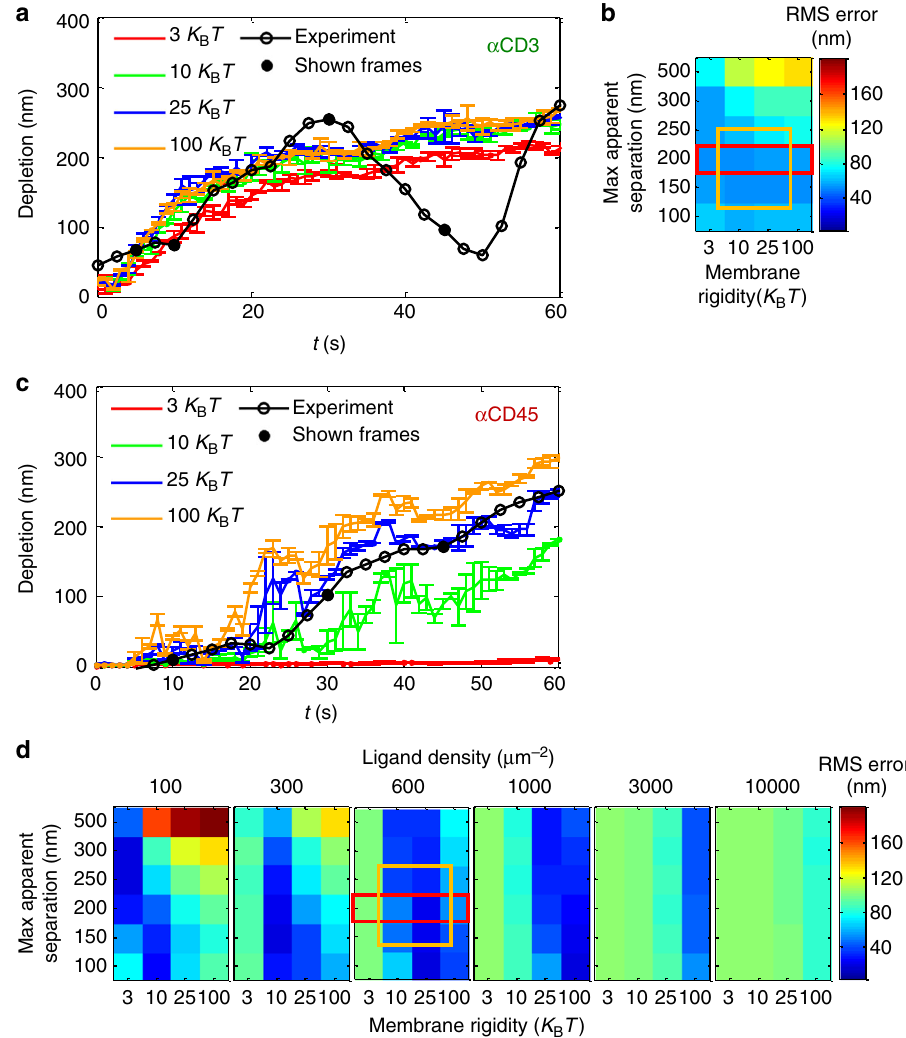
Fig. 5 Modelling and simulations serve to quantify the effect of physical properties on the KS extent and dynamics. a The depletion distance of simulated cells on α CD3 ε -coated coverslip, as a function of time for a range of simulated rigidities. b The RMS error (in nm) of the simulated and experimental depletions under a range of rigidity and contact radii. Highlighted in red are the shown conditions in a . Highlighted in orange are the conditions that showed the most robust results (for stimulated and unstimulated cells). c The depletion distance of simulated cells on α CD45-coated coverslip, as a function of time for a range of simulated rigidities. d The RMS error of the simulated and experimental depletions under a range of rigidity and contact radii (within single matrices) for a range of α CD45 ligand densities (different matrices). Highlighted in red are the shown conditions in c . Highlighted in orange are the conditions that showed the most robust results (for stimulated and unstimulated